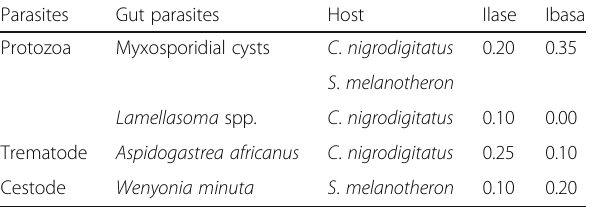
Table 10 Parasitic infection of Chrysichthys nigrodigitatus and Sarotherodon melanotheron in Ibasa and Ilase creeks, Lagos